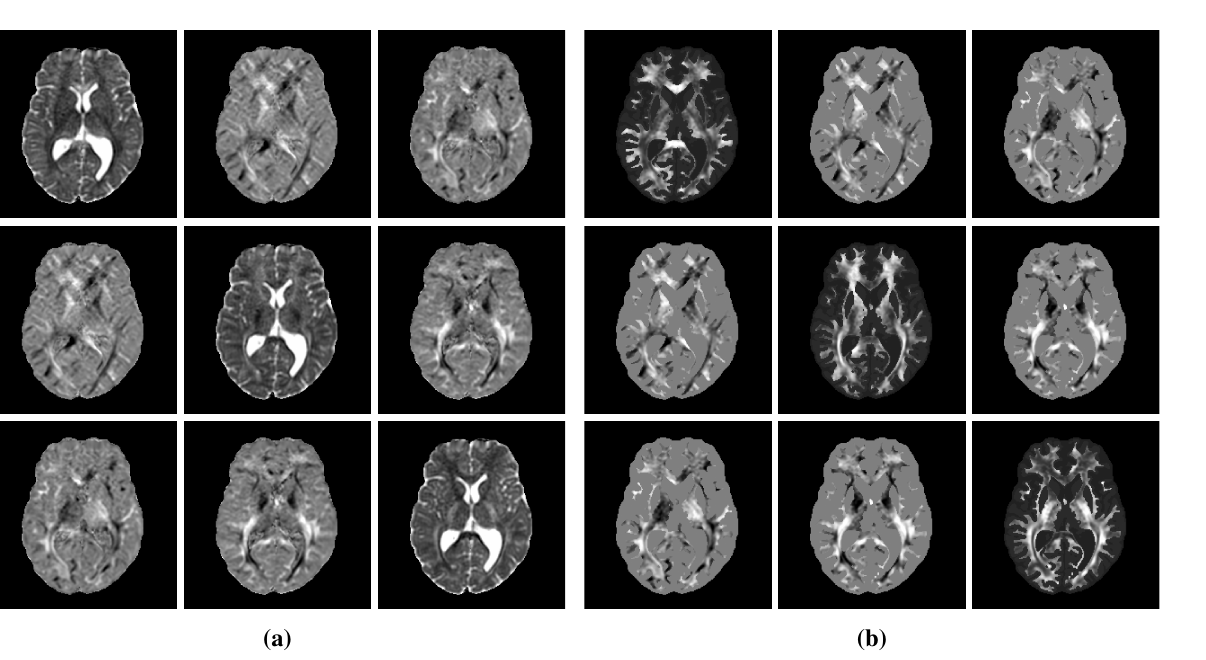
Figure 2. Example of processed DTI data. ( a ) DTI-derived water diffusion tensor field after susceptibility- induced distortion, eddy currents, and patient motion correction using FSL [33]. ( b ) Tumor diffusion ten- sor field with increased anisotropy in white matter ( a = 10) and scaled diffusivity ( d gray / d white = 0.1) built from the water diffusion tensor field in panel ( a ) and the brain map in Figure 1c as described in Section 2.3.6. The subpanel located at row i and column j of panels ( a ) and ( b ) corresponds to the tensor component d i , j